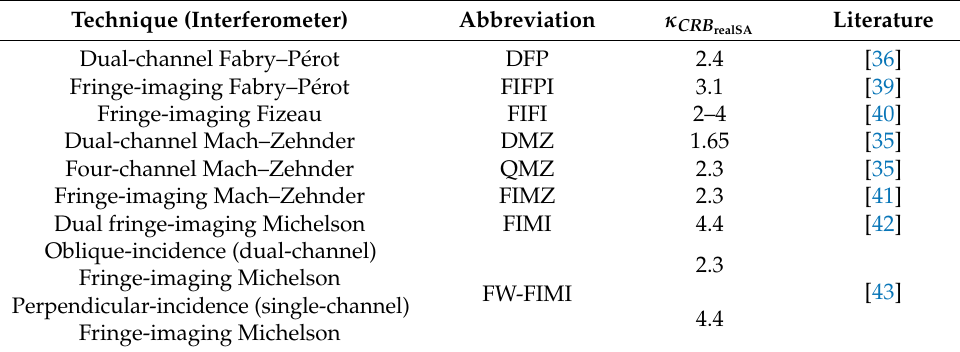
Literature realSA